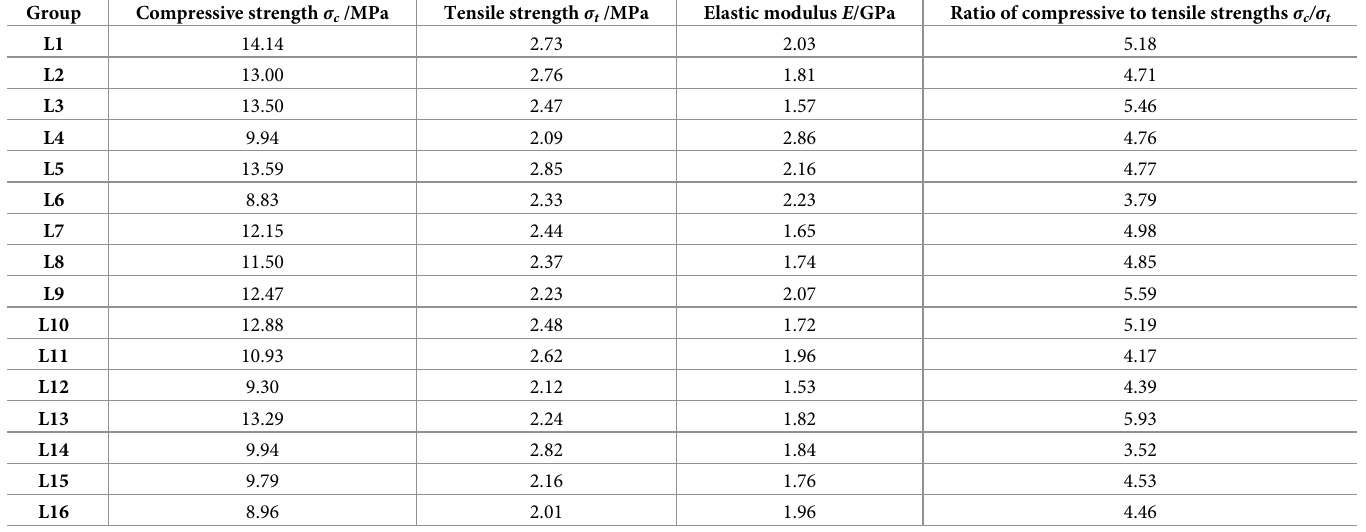
Table 3. Test results of orthogonal ratio.